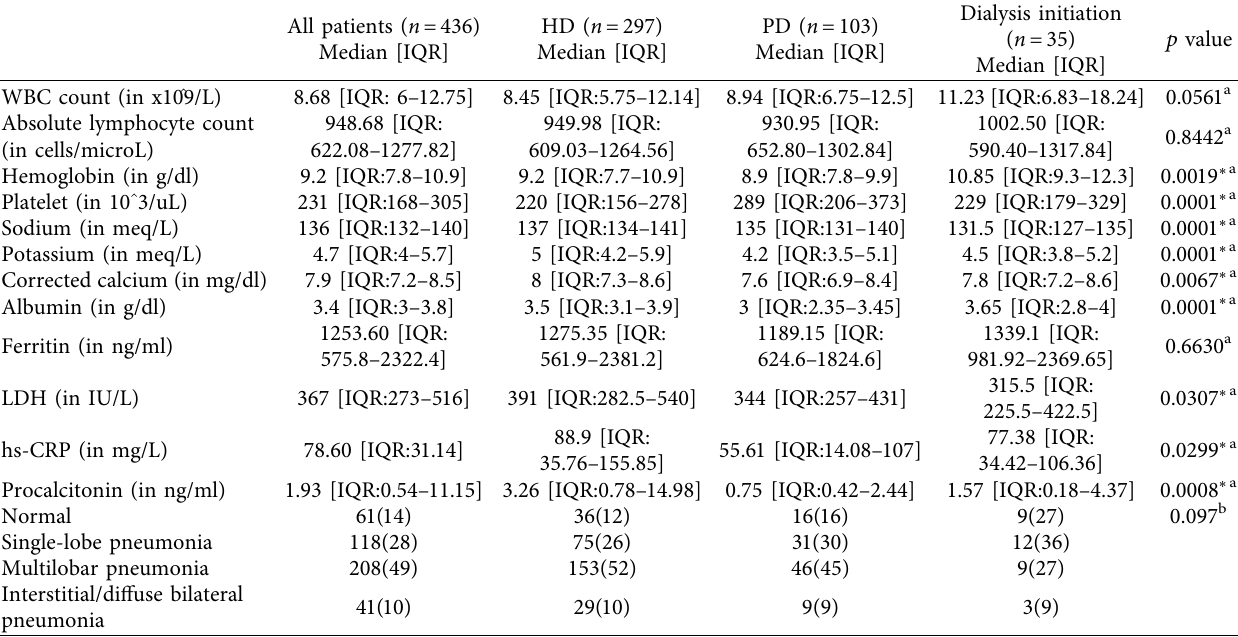
Table 2: Baseline laboratory and radiologic findings of CKD V patients with COVID-19 ( n � 436).